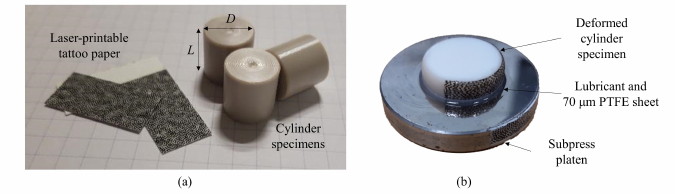
Figure 2. Specimen preparation: ( a ) machined cylinder compression specimens and laser-printed speckle pattern film; and ( b ) consistent deformation of a specimen and DIC pattern under large